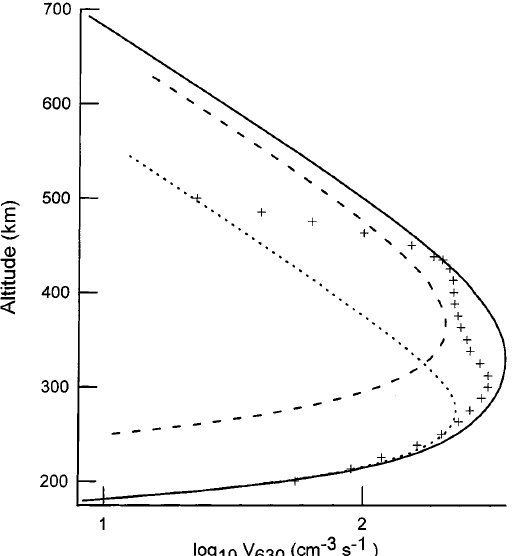
Fig. 2. Observed ( crosses ) and calculated ( lines ) 630 nm volume emission rates at 05:51:40–05:51:51 UT on August 4 in the SAR-arc region. The modelled volume emission rates were obtained when the IZMIRAN model includes the additional heating rate of the electron gas in the plasmasphere q (cid:136) 1 : 05eVcm (cid:255) 3 s (cid:255) 1 and the fluxes of precipitating electrons of Fig. 1 ( solid line ) for the geomagnetic storm period. The dotted line shows the volume emission rate from the IZMIRAN model with the fluxes of precipitating electrons and without the additional heating rate of the electron gas in the plasmasphere. The dashed line represents the IZMIRAN model results with q (cid:136) 1 : 05eVcm (cid:255) 3 s (cid:255) 1 in the plasmasphere and without O (cid:133) 1 D (cid:134) formation by collisions between O (cid:133) 3 P (cid:134) and